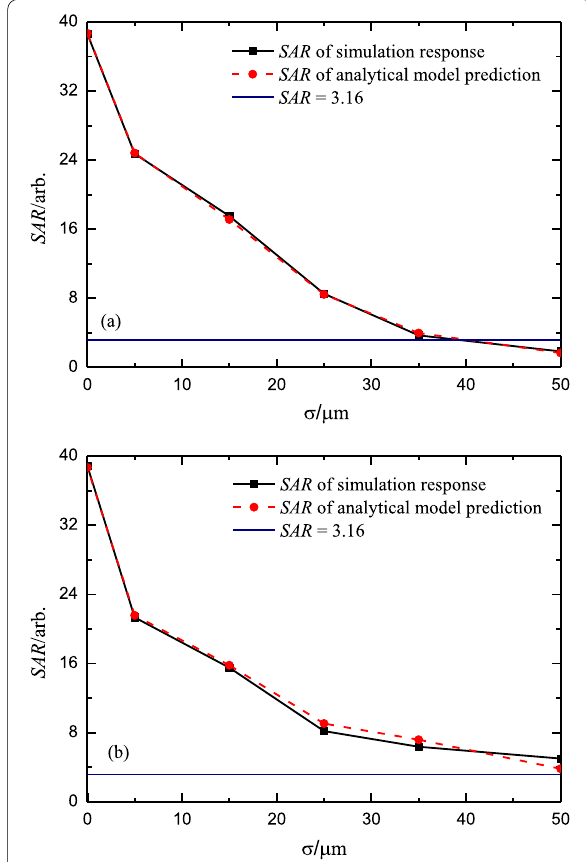
predictions SAR of analytical model under a rough front surface and b rough back